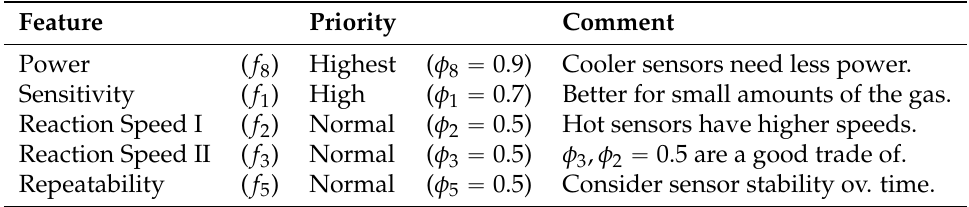
Table 4. Priorities of the features used for the exemplary